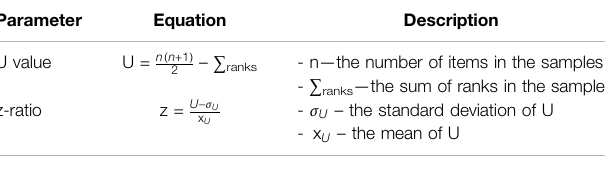
for pH and Pb, and the lowest for EC. Detailed analyses are